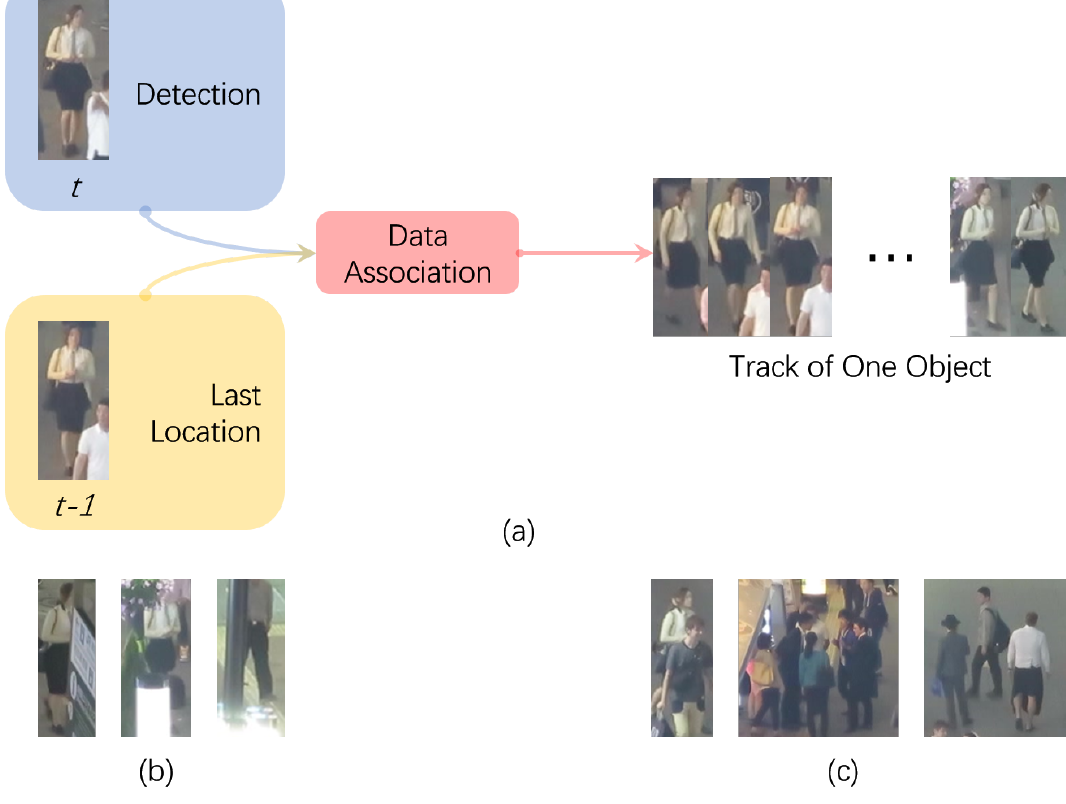
Figure 1. ( a ) One example of the overall tracking-by-detection paradigm in multiple object tracking (MOT). At time t , the MOT method matches the last location of a certain object and aligns the track with the upcoming detection provided by an external detector. Eventually, the goal is to form a reasonable track of that object by repeating this process throughout the video. ( b ) Some examples of occlusion under a MOT scenario. ( c ) Some examples of object